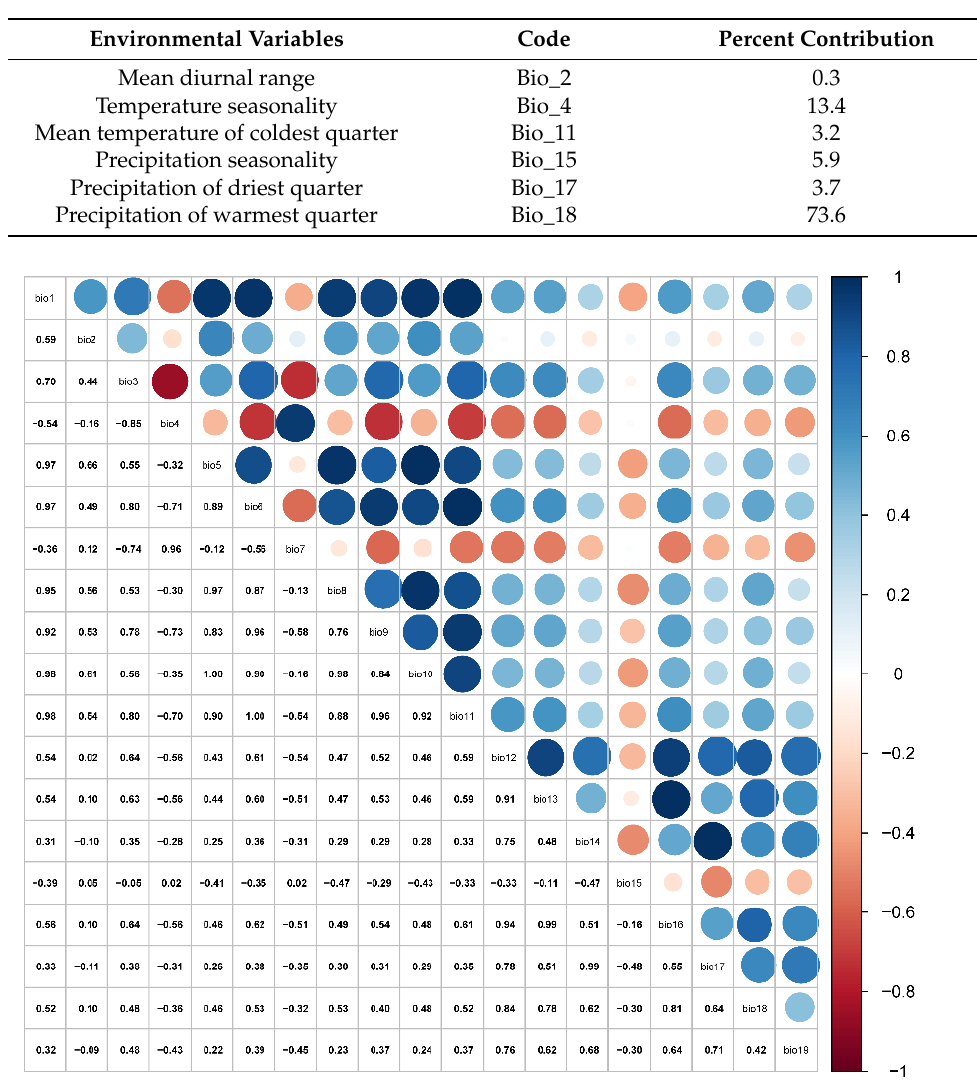
Figure 2. Pearson’s correlation analysis of 19 environmental variables. Correlation coefficients ranges between − 1 and 1. Positive correlations are represented in blue, while negative correlations are represented in red. The bigger and darker the circle is, the greater the correlation is. Table 1. Environmental variables used for modeling and their permutation importance.